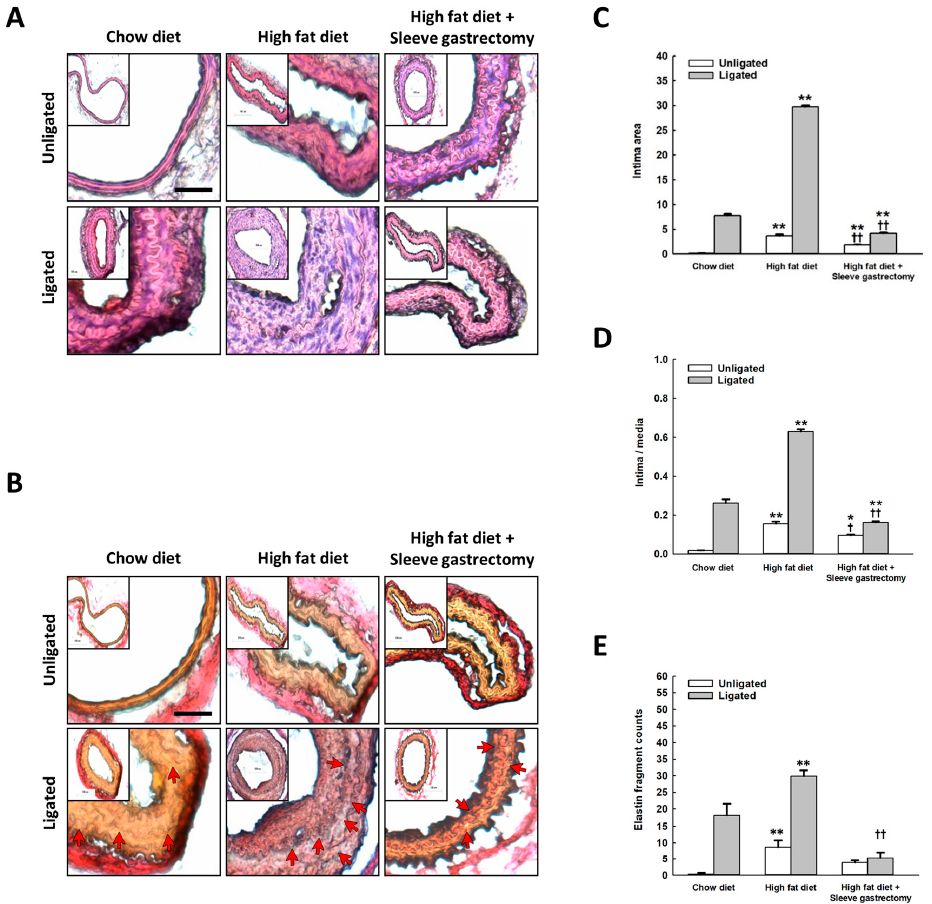
Figure 3. SG attenuated HFD-induced intimal thickening. Representative light micrographs from the ligated left common carotid artery of the mice. H&E and VVG staining were performed ( A , B ) Intima, media areas, intima/media area ratio, and arterial fragmentation counts in all groups were measured. Two-way analysis of variance was performed with one treatment parameter being normal chow, HFD, and HFD with SG, and the other parameter being carotid ligation/no carotid ligation. A p -value < 0.05 was considered to be statistically significant. ( C – E ) (n = 6 per group), Scale bars = 100 µ m. * High-fat diet (HFD) compared with chow diet (CD) in mice with or without carotid ligation, * p < 0.05, ** p < 0.005, †† p <